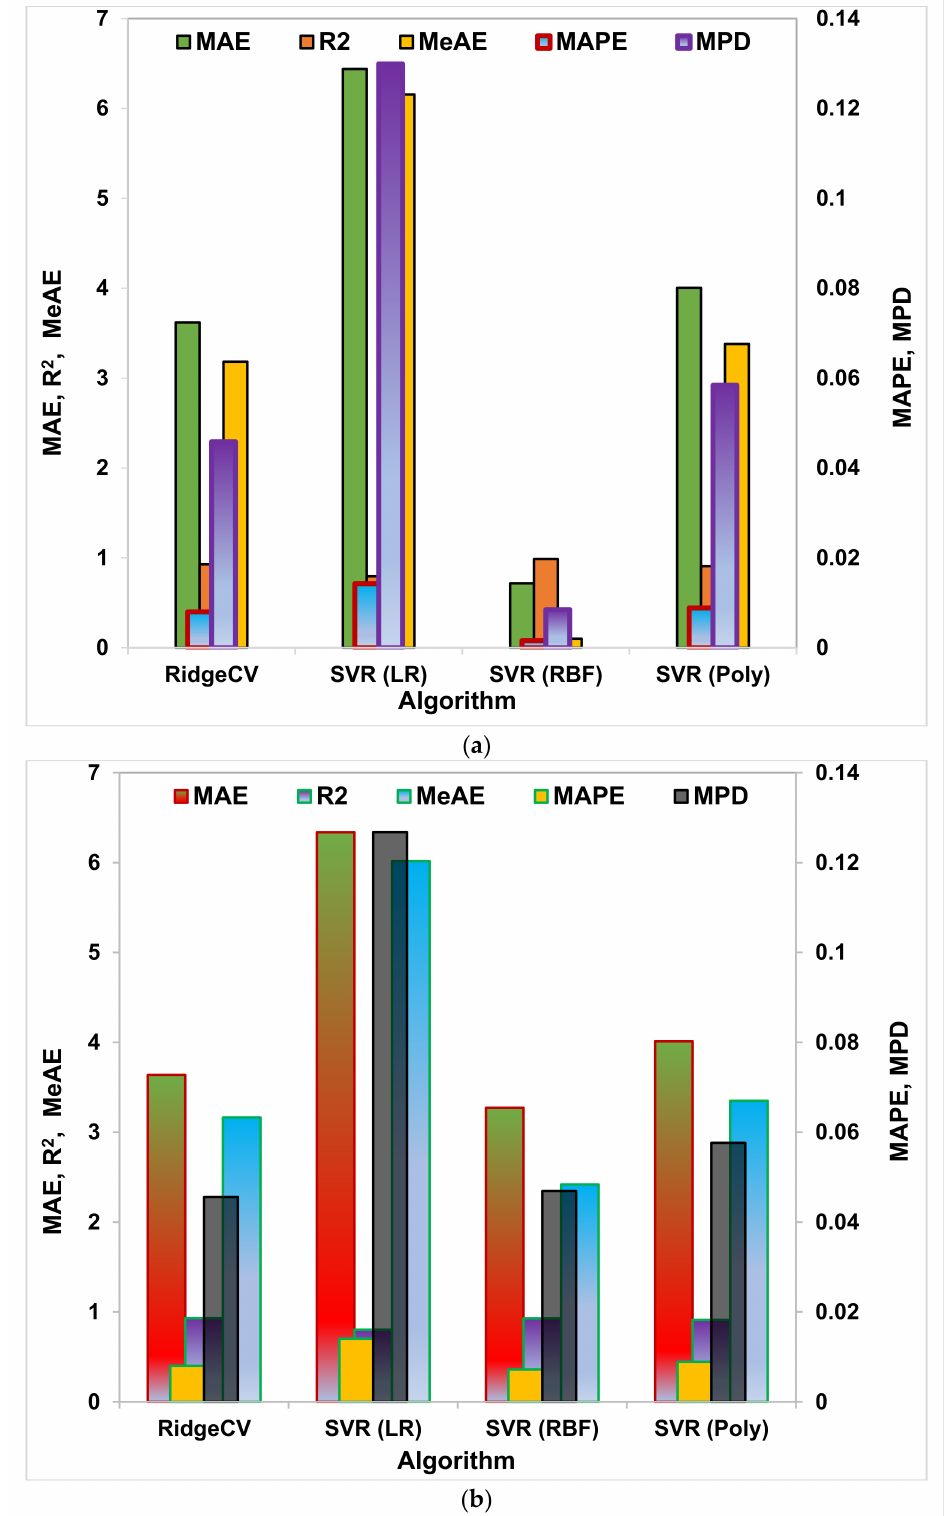
Figure 17. Assessment of SVR (LR), SVR (RBF), and SVR (Poly.) algorithms compared with RidgeCV used for ( a ) training and ( b ) testing of energy output data. (R 2 is shown as R2 in the graph